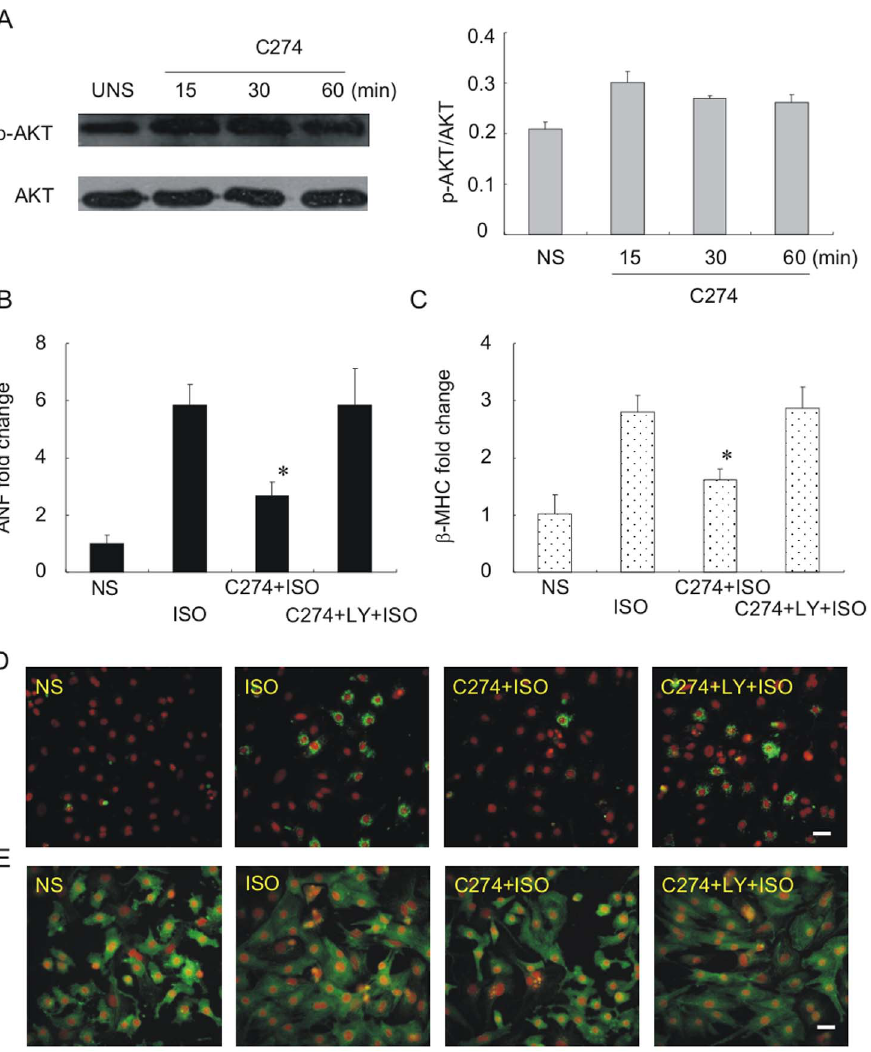
Figure 4. PI3K-Akt signaling pathway is required for the antihypertrophic effect of CpG-ODN. (A) induction of Akt phosphorylation by C274 (5 m g/ml x 12 h) as demonstrated by Western blot assays. Plotted on the right is quantitative analysis of data shown in the left panel. Band density was determined and analyzed using ImageJ. (B, C) isoproterenol-induced increase in ANF and b -MHC mRNAs ( second bars from left ) was inhibited by C274 ( third bars from left ) but no longer inhibited by C274 in cells pre-incubated with a pan-PI3K inhibitor LY294002 ( fourth bars from left ). (D) C274 failed to prevent isoproterenol-induced ANF expression at protein level in cells pretreated with LY. (E) C274 failed to normalize isoproterenol-induced morphological alterations in myocytes pretreated with LY. Scale bar=20 m